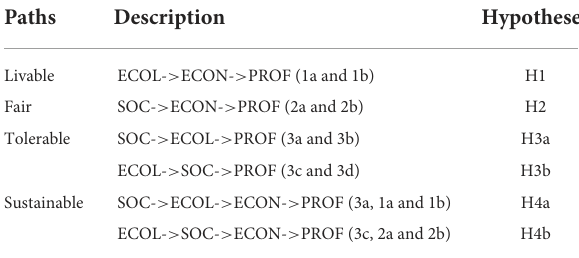
TABLE 1 Summary of sustainable development paths related to IR and the